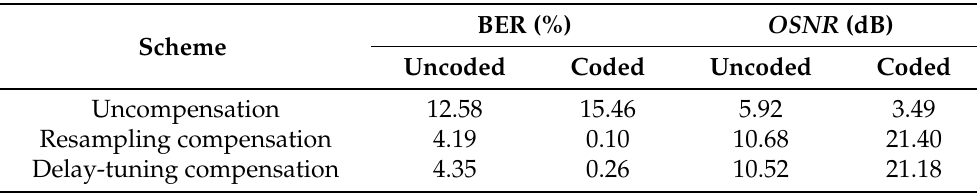
Table 2. BER and OSNR under different communication schemes with LMS equalizer at uncoded and coded conditions for sea